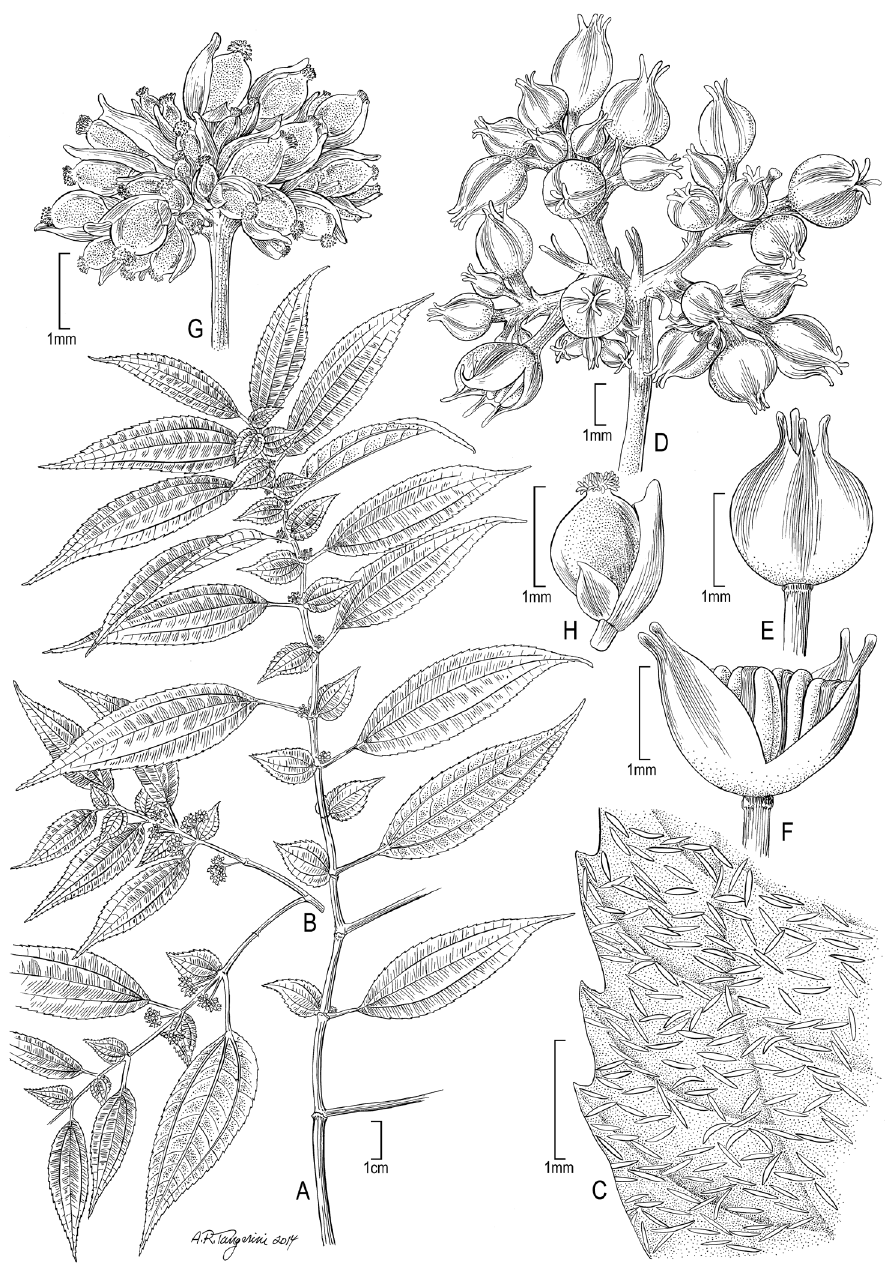
Figure 1. Pilea matthewii . A Habit of pistillate plant; note the sessile unequal leaf laminae at each node B Branchlet of staminate plant; note the unequal leaf laminae at each node C Leaf detail (upper surface of minor lamina) showing cystoliths D Staminate inflorescence E Staminate flower F Staminate flower showing anthers G Pistillate inflorescence H Pistillate flower. ( A – C , G , H from L.J. Dorr et al. 4994 (US); D – F from B. Stergios et al. 20080